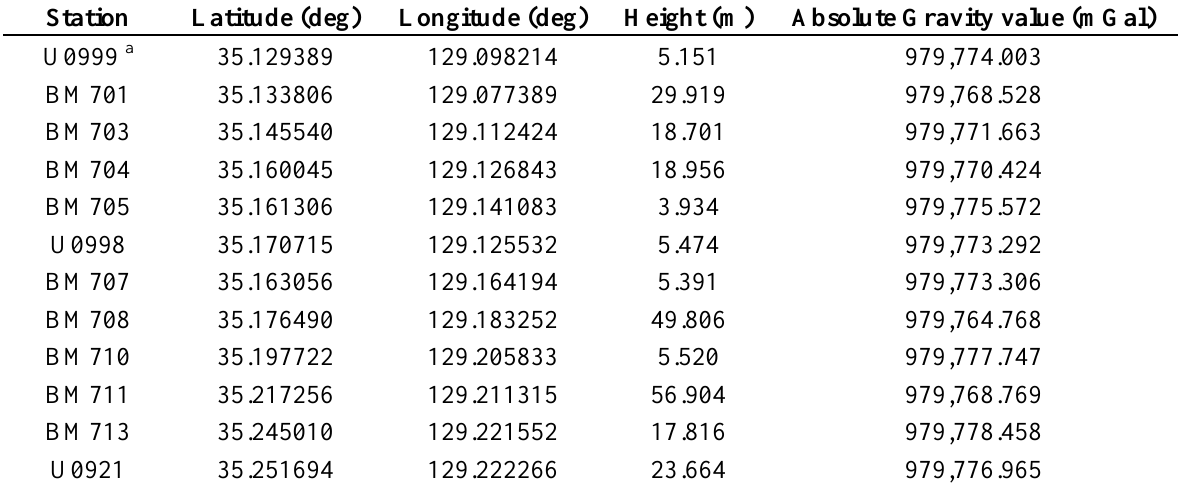
Table 4. Absolute gravity values after network adjustment